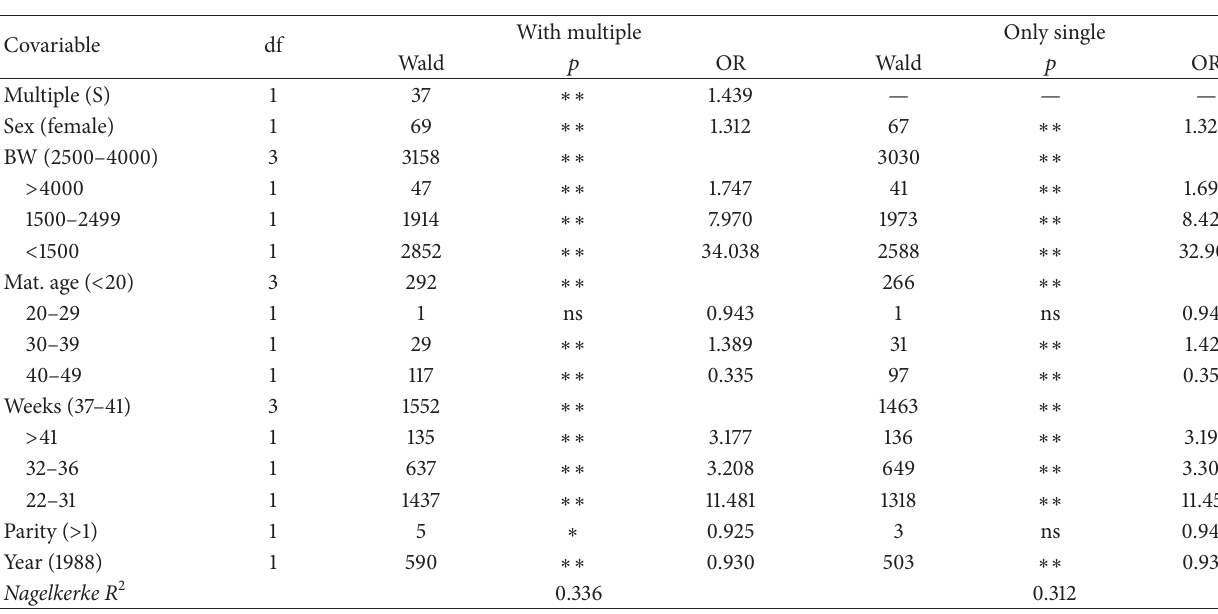
Table 5: (a) 1988–95 and 2010-11 forward (Wald) binary logistic regressionparameters. Dependent variable: early neonatal deaths. (b)1988–95 and 2010-11 forward (Wald) binary logistic regression parameters. Dependent variable: perinatal